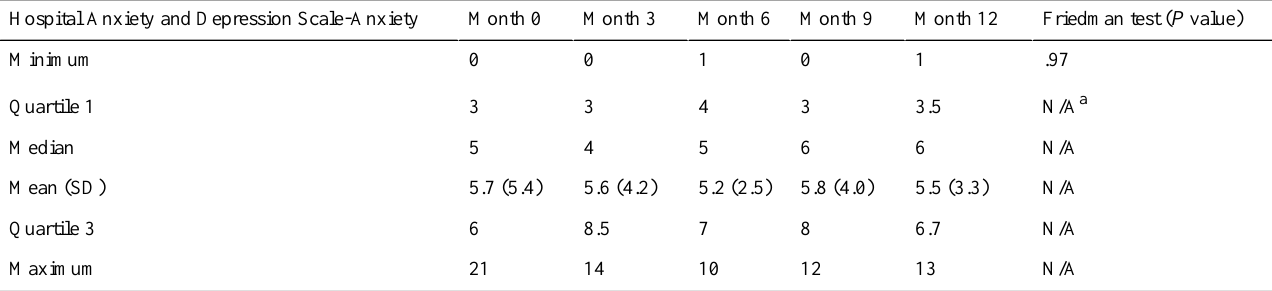
Table 11. Informal caregivers’anxiety and depression scores during the year observation period.